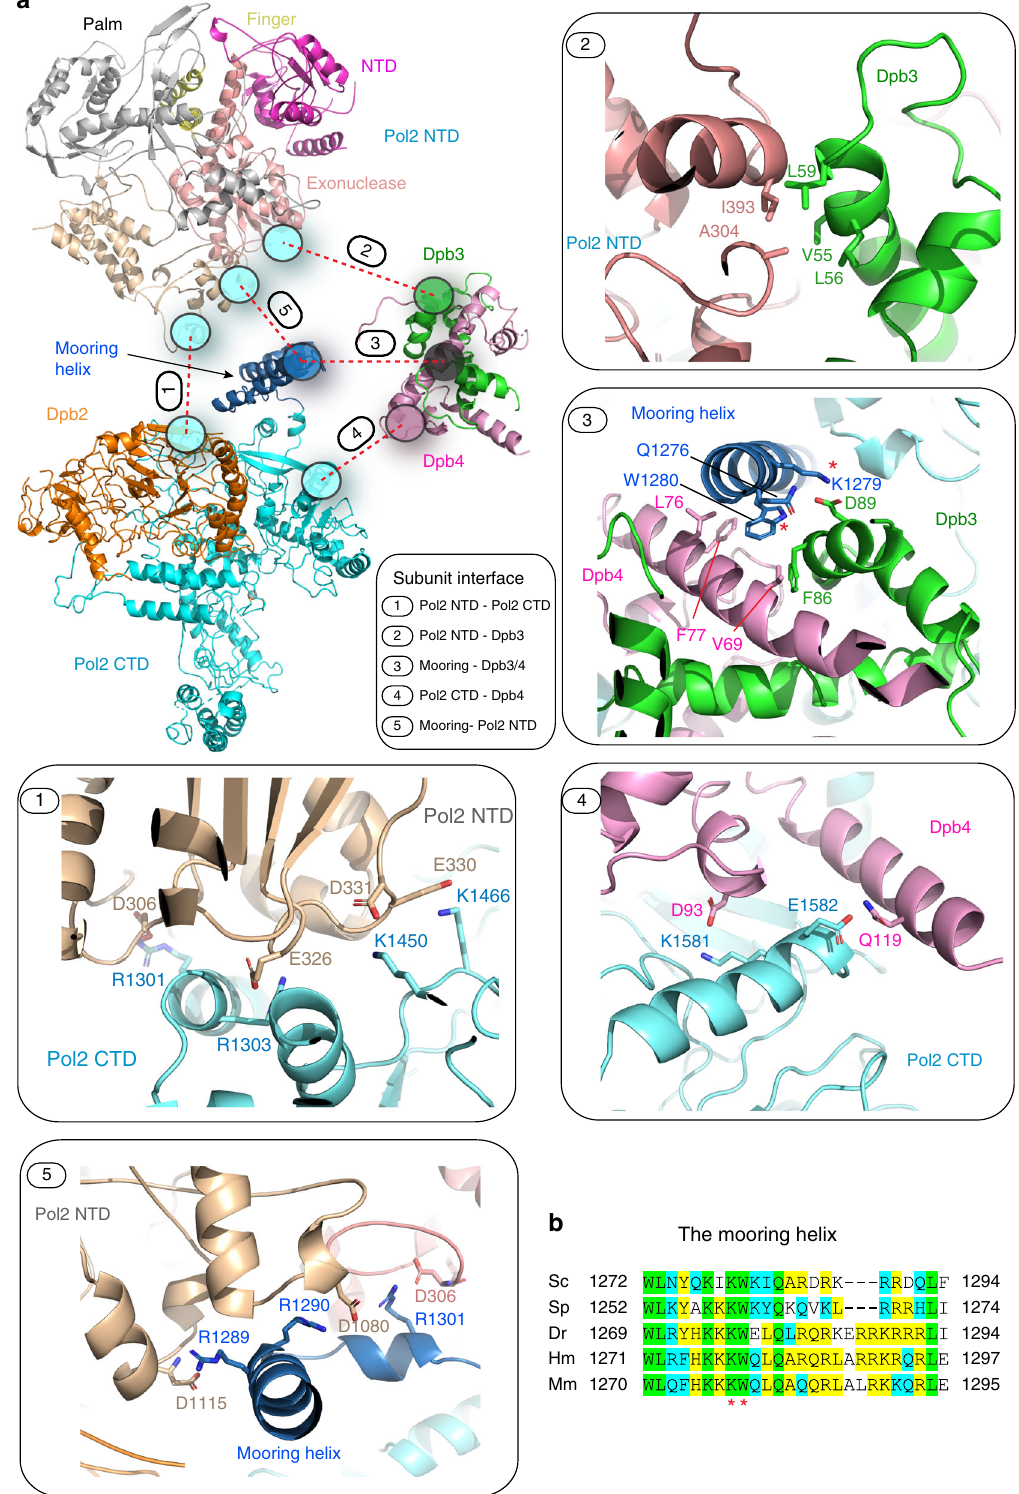
Fig. 3 Domain – domain interactions within Pol ε . a Pull-apart of the structure. Each circle represents the contact region between two domains. The oval with a number indicates the interaction that is enlarged and shown in the numbered enlarged boxes. 1: between Pol2 NTD and CTD; 2: between Pol2 NTD and Dpb3; 3: between mooring helix and Dpb3 – 4; 4: between Dpb3 and Dpb4; and 5: between mooring helix and Pol2 NTD. b Sequence alignment of the mooring helix in Sc ( S. cerevisiae ), Sp ( S. pombe ), Dr ( D. reos ), Hs ( H. sapien ), Mm ( M. muscarus ). The red asterisks indicate conserved residues involved in interactions with Dpb3 –